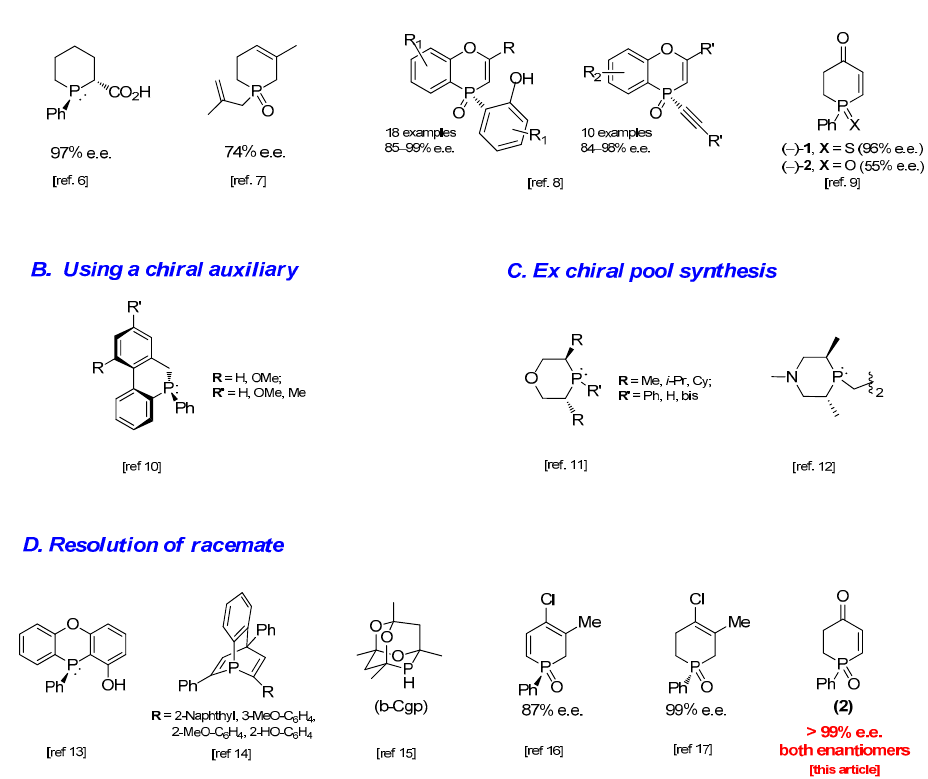
Figure 1. Reported optically active phosphinanes and type of reactions used in their synthesis.